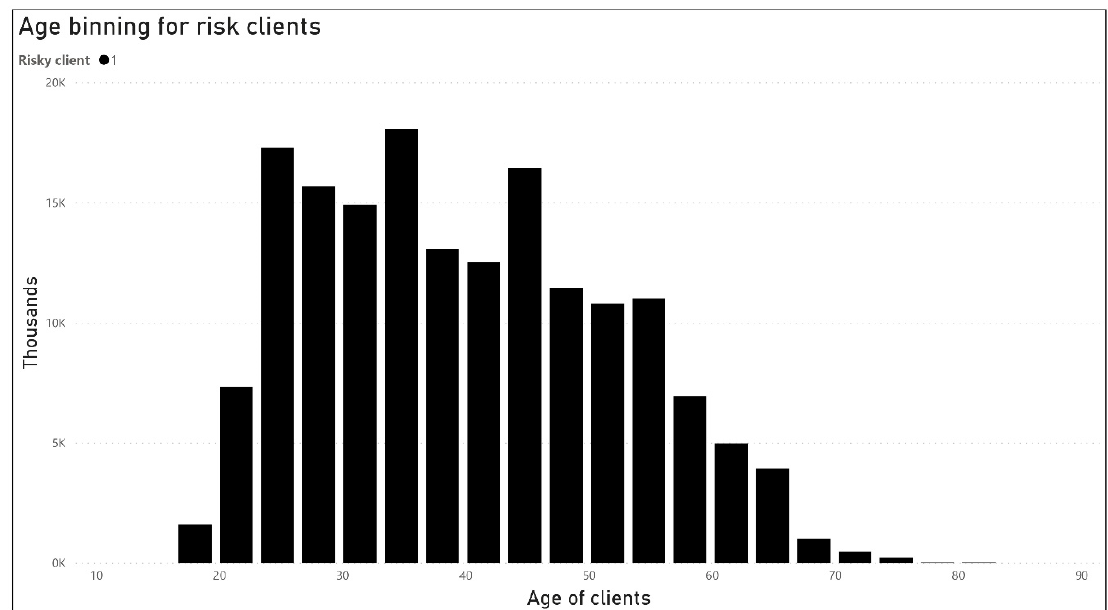
Figure 7. Binning of age attribute.